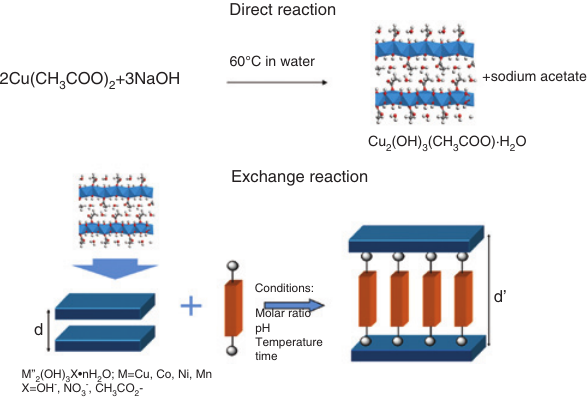
Figure 2: Summary of the main types of reaction routes used for synthesizing hybrid transition metal hydroxides. Direct reaction of a metal salt in aqueous solution with an alkaline base leads to metal hydroxide by precipitation. Direct reaction can be carried out under hydrothermal conditions. Another route consists in starting from a pre-formed layered hydroxide, which is further hybridized by anion exchange reaction.